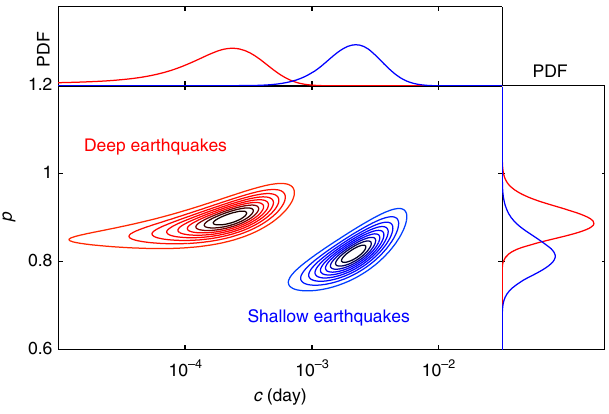
Fig. 1 In fl uence of depth on the aftershock decay rate in zones of strike-slip faulting in California. Bayesian posterior densities of { c , p } in two depth intervals of 4 – 6 km (blue, 557 events) and 9 – 13 km (red, 556 events) considering a single stack of aftershocks for all the major strike-slip faults. Contours are the deciles of each distribution. Curves show the probability distribution functions of the marginal posterior distributions of p (left) and c